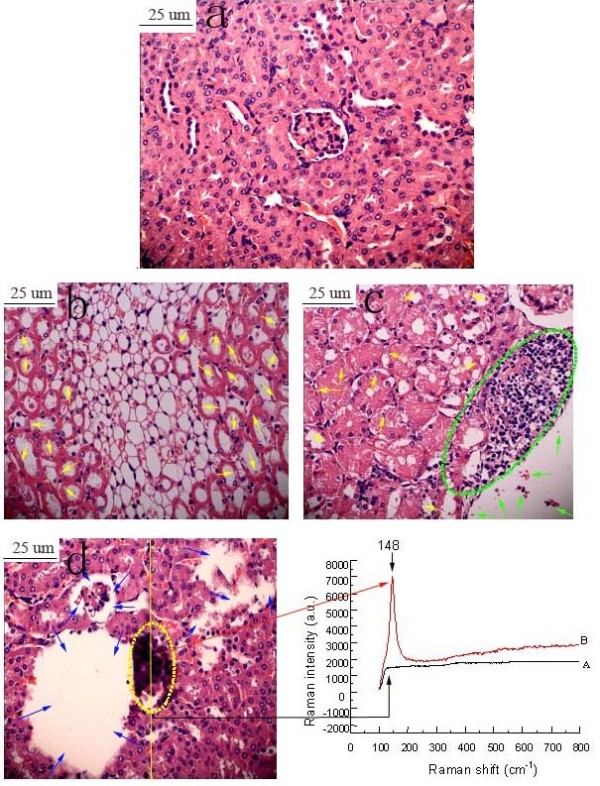
Histopathological observation of kidney caused by intragastric administration of TiO2 NPs for 90 consecutive days. (a) Control, (b) 2.5 mg/kg TiO2 NPs, (c) 5 mg/kg TiO2 NPs, (d) 10 mg/kg TiO2 NPs. Yellow arrows indicate apoptosis or vacuolization, green arrows indicate cell abscission, fatty degeneration or cell necrosis, green virtual circle indicates infiltration of inflammatory cells, blue arrows indicate tissue necrosis or disorganization of renal tubules. Yellow virtual circle indicates TiO2 NPs aggregation. Arrow A spot is a representative cell that not engulfed the TiO2 NPs, while arrow B spot denotes a representative cell that loaded with TiO2 NPs. The right panels show the corresponding Raman spectra identifying the specific peaks at about 148 cm-1.